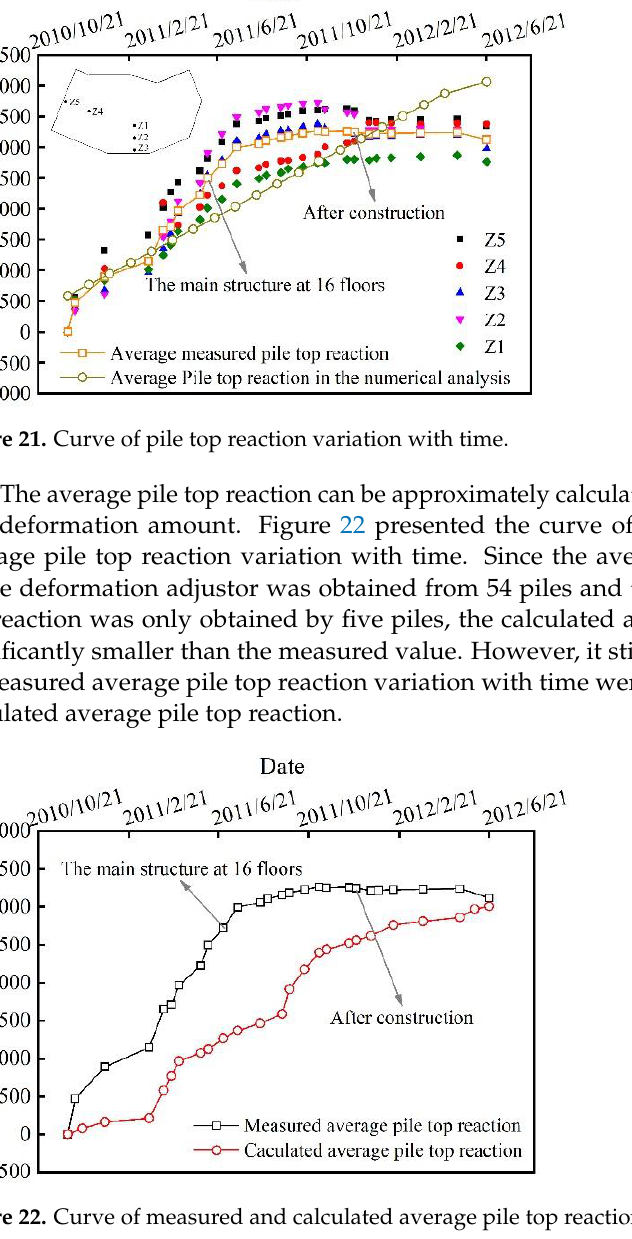
Figure 22. Curve of measured and calculated average pile top reaction variation with time .